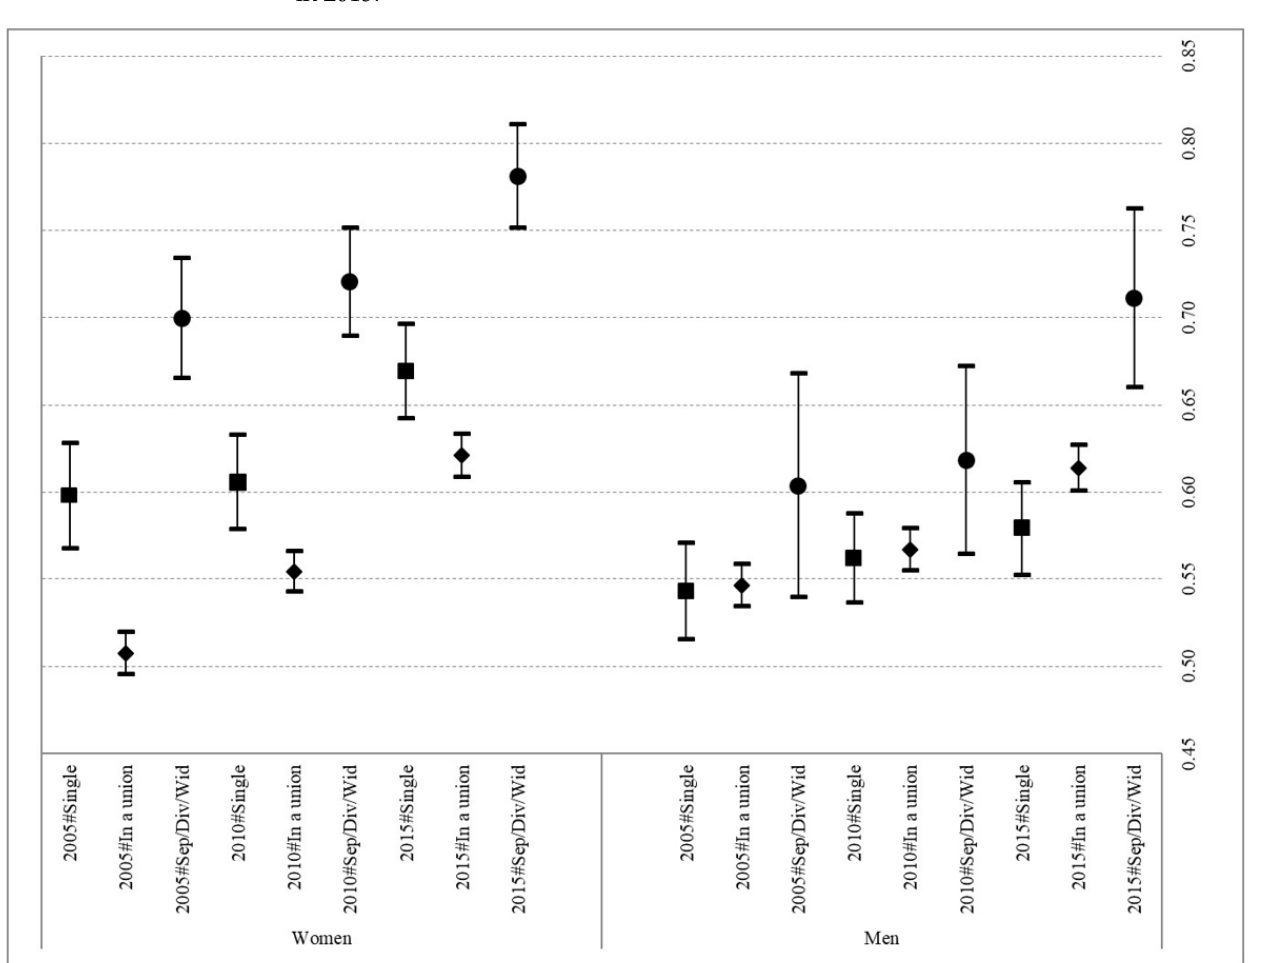
Figure 2. Predicted probabilities of having difficulties to make ends meet according to partnership status and year in Spanish women and men aged 30–59. 2005, 2010 and 2015. Source: Spanish sample EU-SILC 2005, 2010 and 2015. Note: Both models control for education, employment status, age, and living with children under the age of 16.